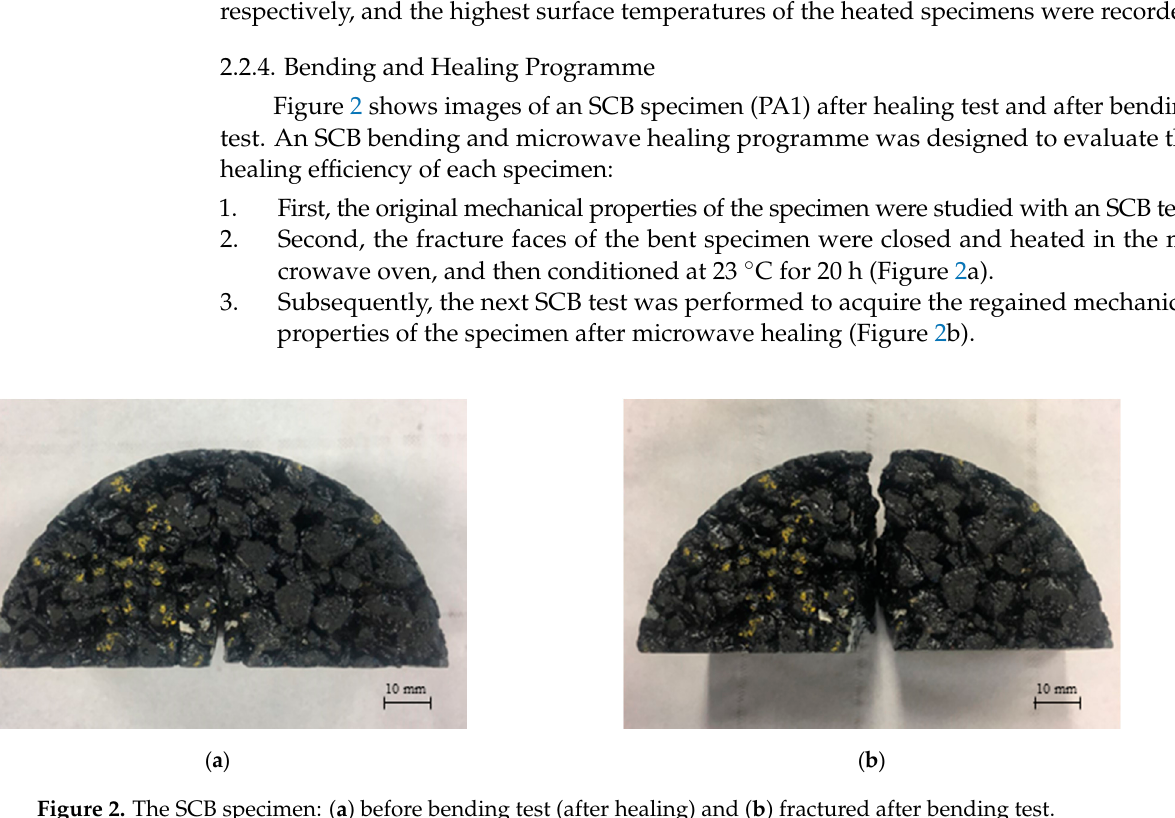
Figure 2. The SCB specimen: ( a ) before bending test (after healing) and ( b ) fractured after bending test.